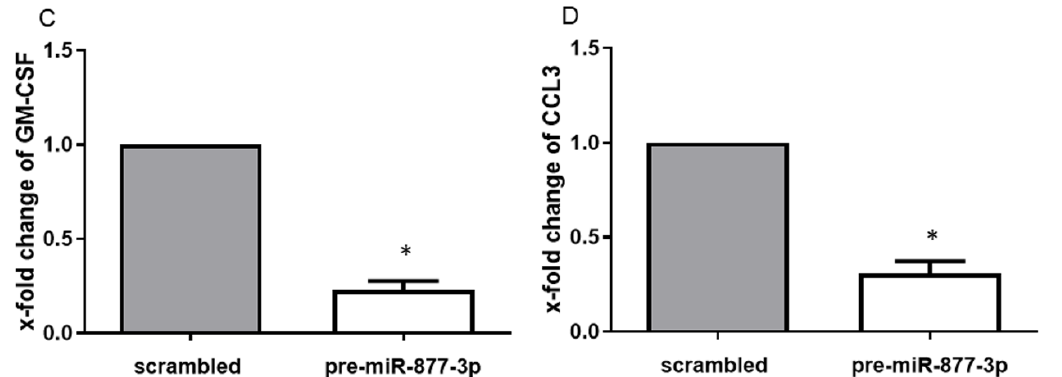
Figure 3. The suppression of the production of chemokines from RA-FLS by the overexpression of miR-877-3p. The transfection of RA-FLS ( n = 3–4) with precursor miR-877-3p (pre-miR-877-3p) for 48 h decreased the productions of GM-CSF ( A ) and CCL3 ( B ) in the culture supernatant compared to the scrambled-RNA-transfected controls, as determined by ELISA. At the mRNA level, transfection of RA-FLS ( n = 4) with pre-miR-877-3p for 48 h decreased the levels of GM-CSF ( C ) and CCL3 ( D ) compared to scrambled-RNA-transfected controls, as determined by SYBR Green real-time PCR. Values are means ± SD. * p < 0.05 vs. scrambled controls.